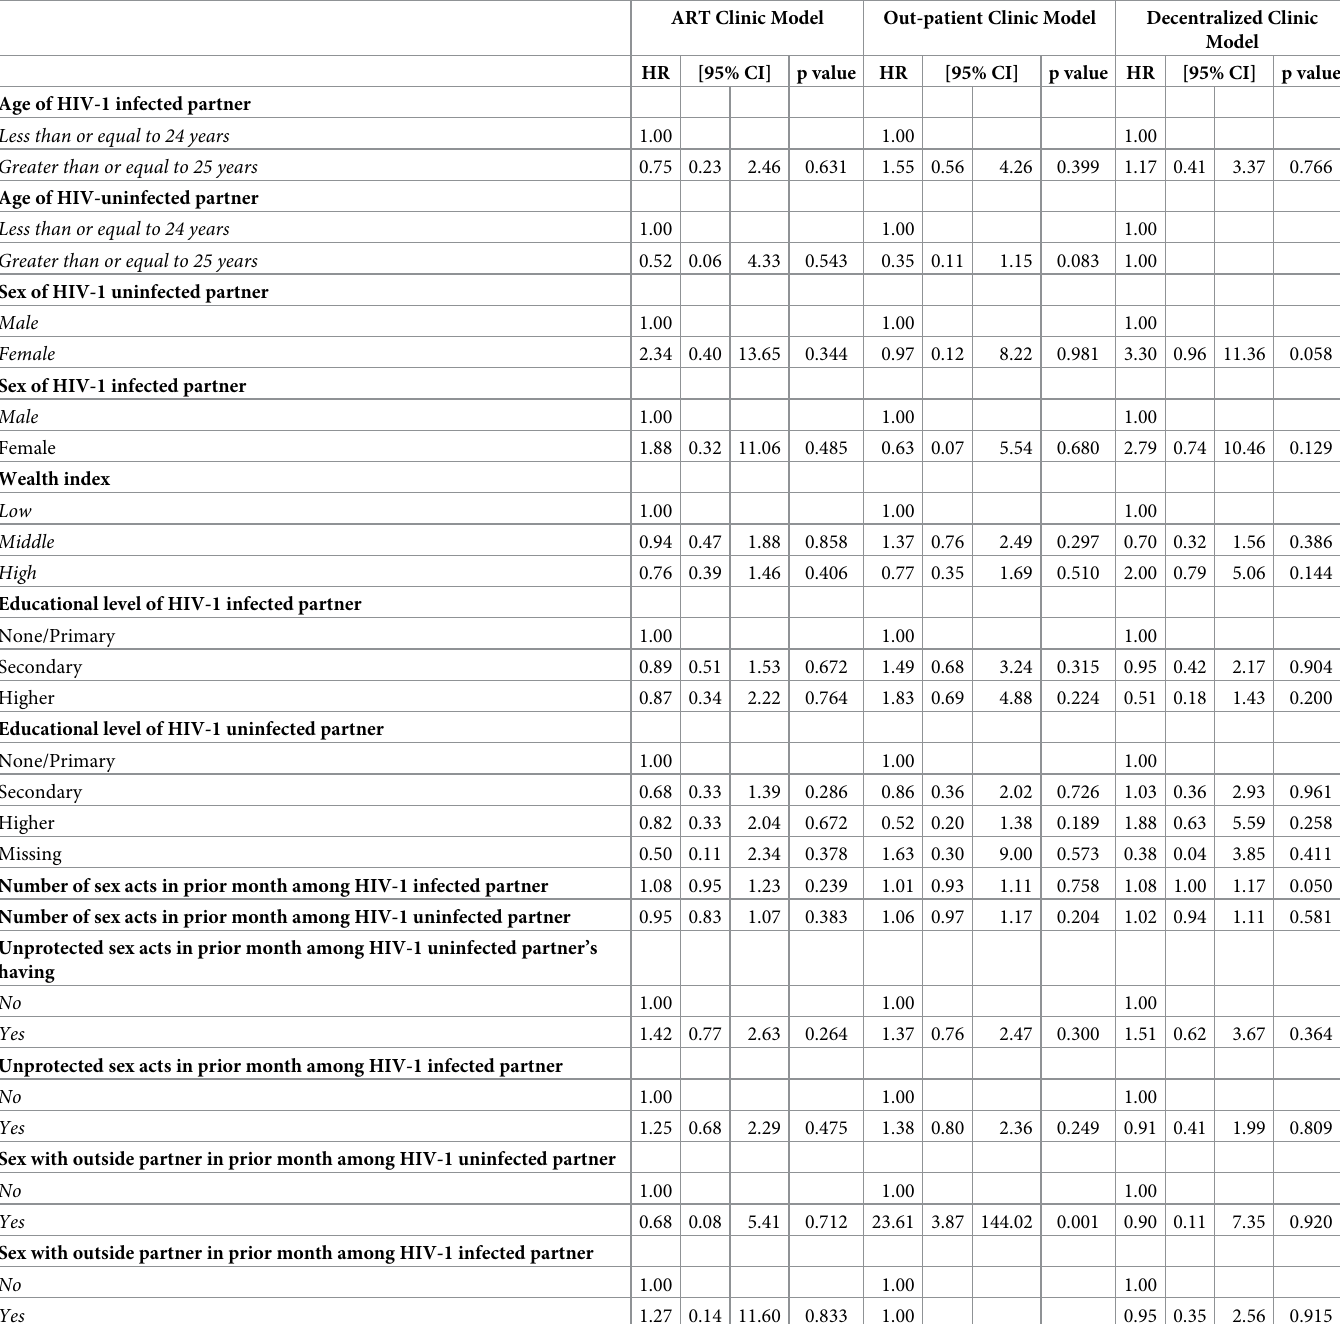
Table 3. Cox regression analysis comparing influence of factors stratified by